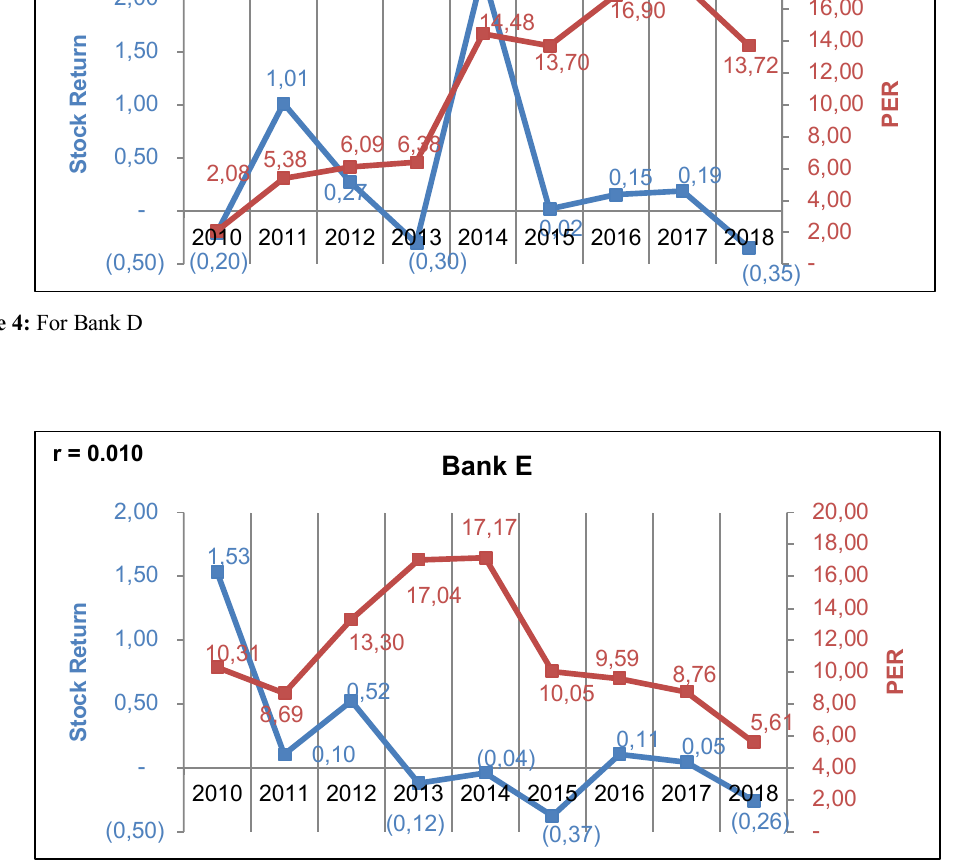
Figure 5: For Bank